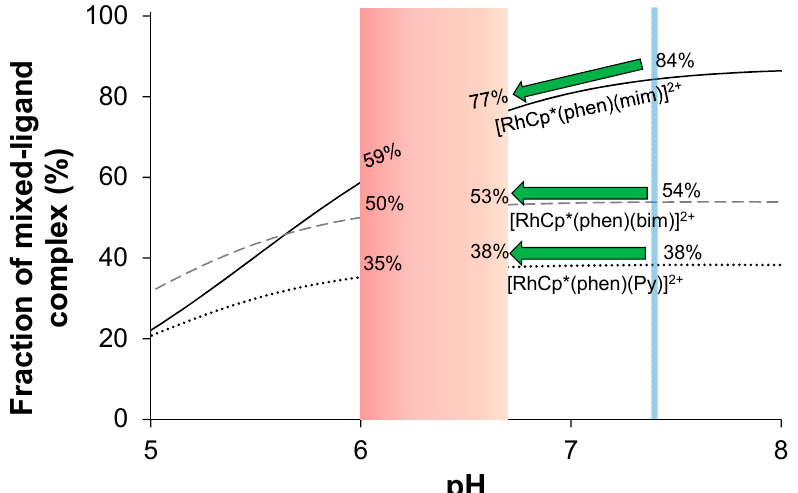
Figure 6. Fractions of the mixed‑ligand complexes of [RhCp*(phen)(H 2 O)] 2+ formed with pyridine, benzimidazole, and 1‑methylimidazole as a function of pH. Formation constants shown in Figure 5 and in Table S2 were used for the calculation. Percentages indicate the fraction at pH = 7.4 (blue line) and in the range between pH = 6.0–6.7 (pink rectangle: possible pH of tumor microenvironment during acidosis).